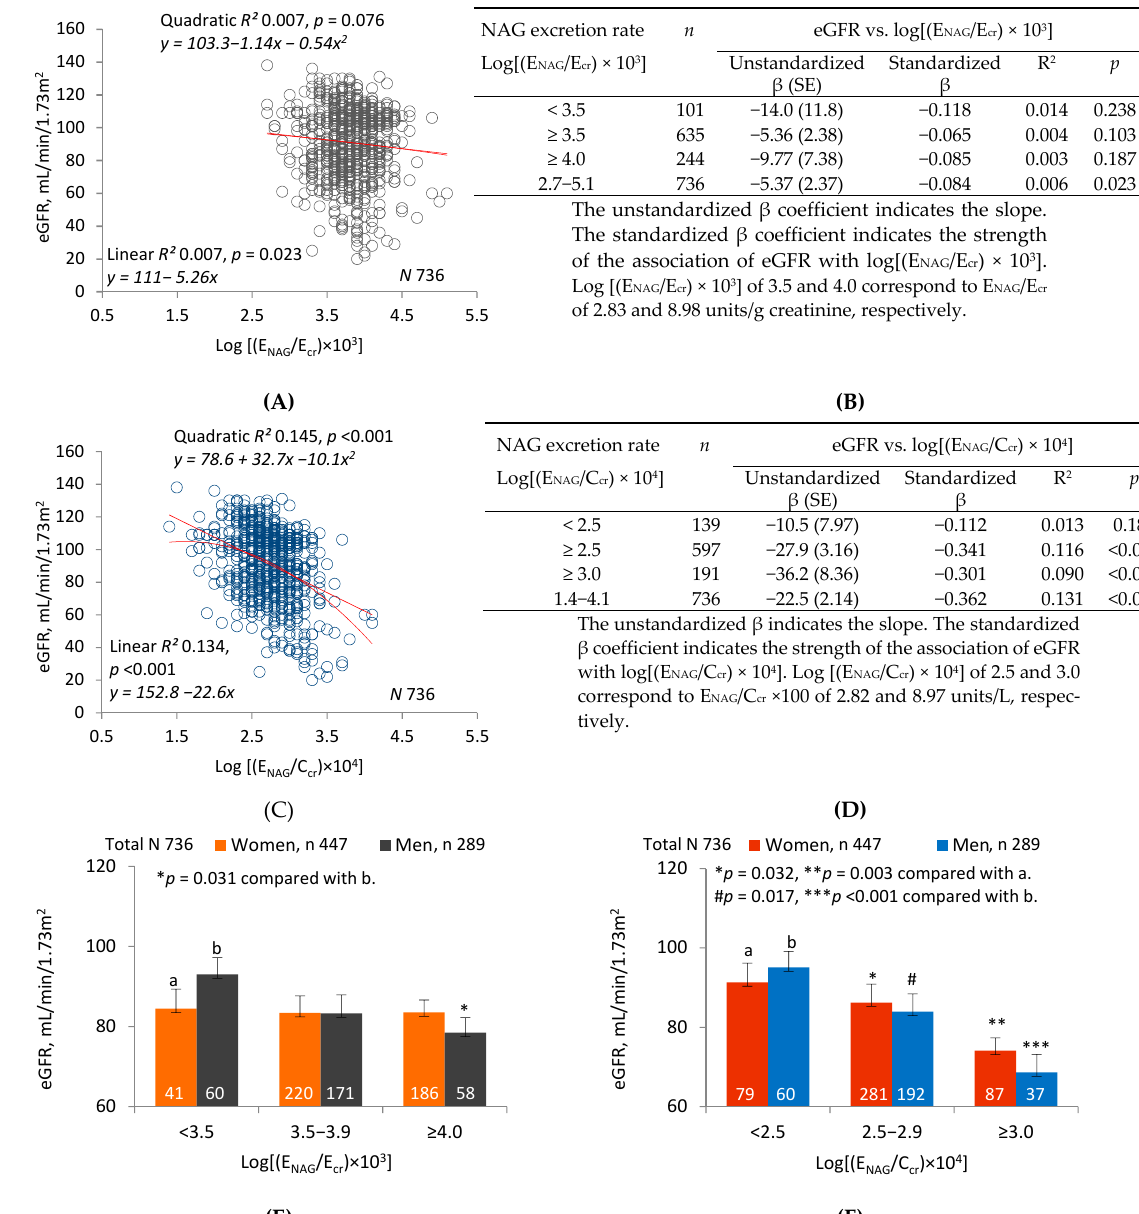
Figure 2. Inverse relationships of eGFR to parameters of NAG excretion. Parameter abbreviations are summarized at the end of the text. Scatterplots in graphs ( A , C ) relate eGFR to log[(E NAG /E cr ) × 10 3 ] and log[(E NAG /C cr ) × 10 4 ] in all subjects. Linear and quadratic equations, their respective coefficients of determination (R 2 ), and associated p -values are provided. In Table ( B ), linear relationships of eGFR to log [(E NAG )/E cr ) × 10 3 ] < 3.5, ≥ 3.5 and ≥ 4.0 are characterized with respective values of subject number ( n ), unstandardized and standardized β , R 2 , and p . In Table ( D ), linear relationships of eGFR to log[(E NAG /C cr ) × 10 4 ] < 2.5, ≥ 2.5 and ≥ 3.0 are characterized with respective values of n , unstandardized and standardized β , R 2 , and p . In graphs ( E , F ), the bars represent the mean eGFR in women and men grouped by ranges of log[(E NAG /E cr ) × 10 3 ] or log[(E NAG /C cr ) × 10 4 ] (NAG excretion levels 1, 2, and 3 from lowest to highest). Numbers of women and men within each NAG excretion level are provided. The letters a and b identify reference values in women and men, respectively, at the lowest rates of Cd excretion. Where appropriate, statistical comparisons are made within each gender between mean eGFR in bars a and b and mean eGFR at higher rates of Cd excretion. The geometric mean (GM) (SD) of E NAG /E cr in groups 1, 2 and 3 is 1.75 (0.65), 5.36 (1.68) and 14.50 (11.98) units/g creatinine, respectively. The GM (SD) of [(E NAG /C cr ) × 100] in groups 1, 2 and 3 is 1.73 (0.66), 5.56 (2.25) and 17.52 (17.16) units/L,